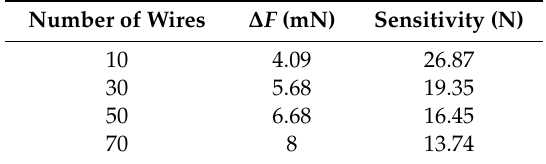
Table 4. Calculation of the sensitivity of the filter considering a distance between wires d = 17.5 µ m.